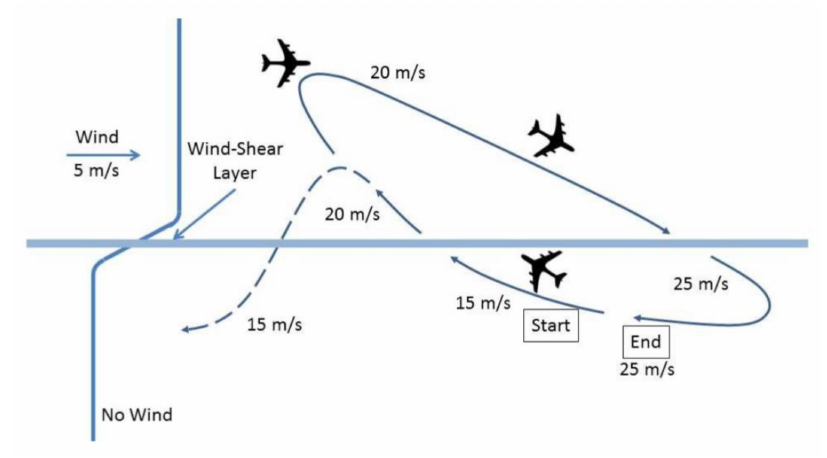
Figure 5. Dynamic soaring maneuver [44].